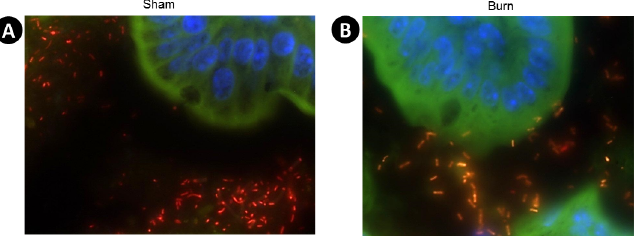
Fig 3. Direct Observation of Enterobacteriaceae in the Small Intestine. Tissue sections were taken from the small intestine of sham or burn injured animals one day after injury, and stained with fluorescently labeled oligonucleotide conjugated probes to label 16s rRNA and counterstained with DAPI to label intestinal nuclei blue. Alexa 555 (Red) EUB 338 probe was used to stain total Bacteria, and Alexa 488 (Green) ENTBAC 183 was used to stain Enterobacteriaceae. Orange depicts co-localization of both probes and bacteria that are Enterobacteriaceae. ( A ) is a representative picture of sham animals and ( B ) is a representative image of burn injury